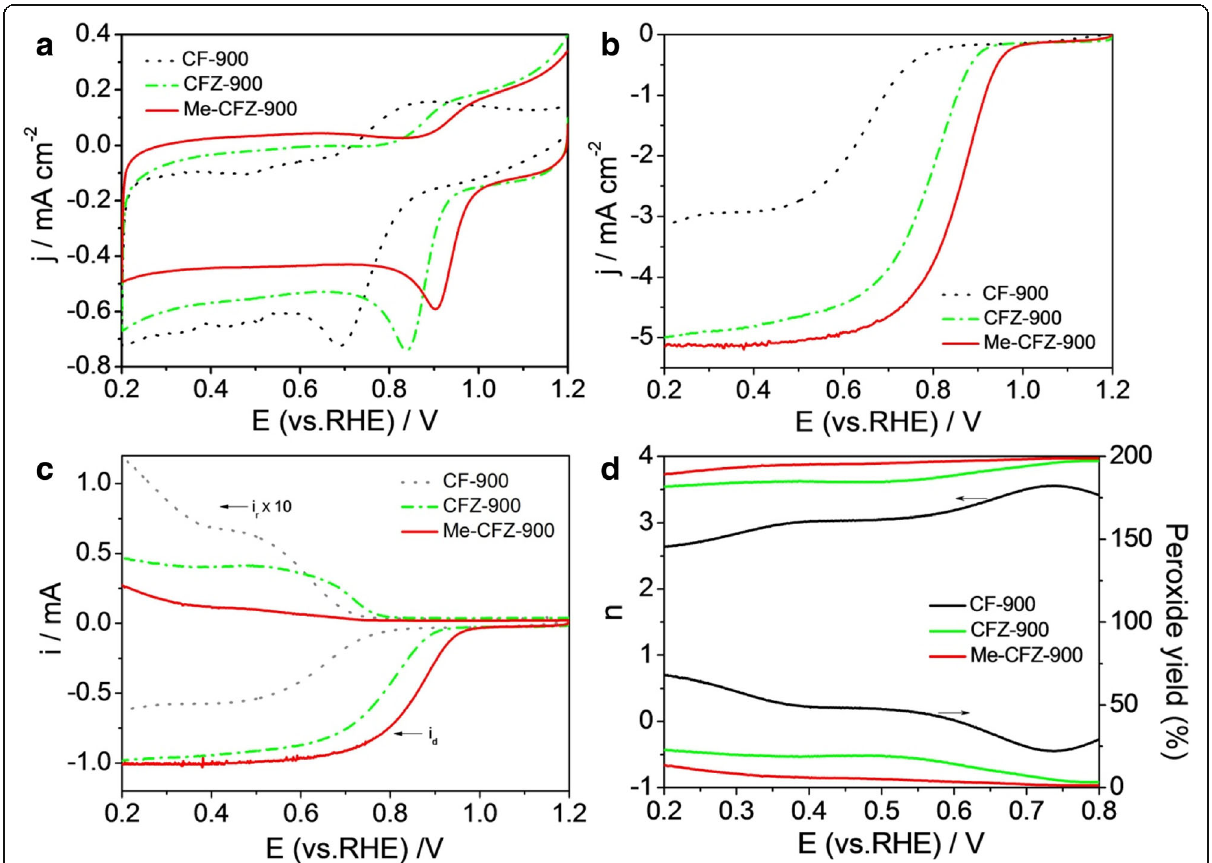
Fig. 5 a CV curves of CF-900, CFZ-900, and Me-CFZ-900 in O 2 -saturated 0.1 mol l − 1 KOH solution. b LSV curves for ORR of CF-900, CFZ-900, and Me-CFZ-900 and 20 wt% Pt/C in O 2 -saturated 0.1 M KOH solution at a rotation speed of 1600 rpm. c Disk and ring currents obtained with LSV on RRDE for CF-900, CFZ-900, and Me-CFZ-900 in O 2 -saturated 0.1 mol l − 1 KOH solution. d The corresponding electron transfer number and H 2 O 2 yield from